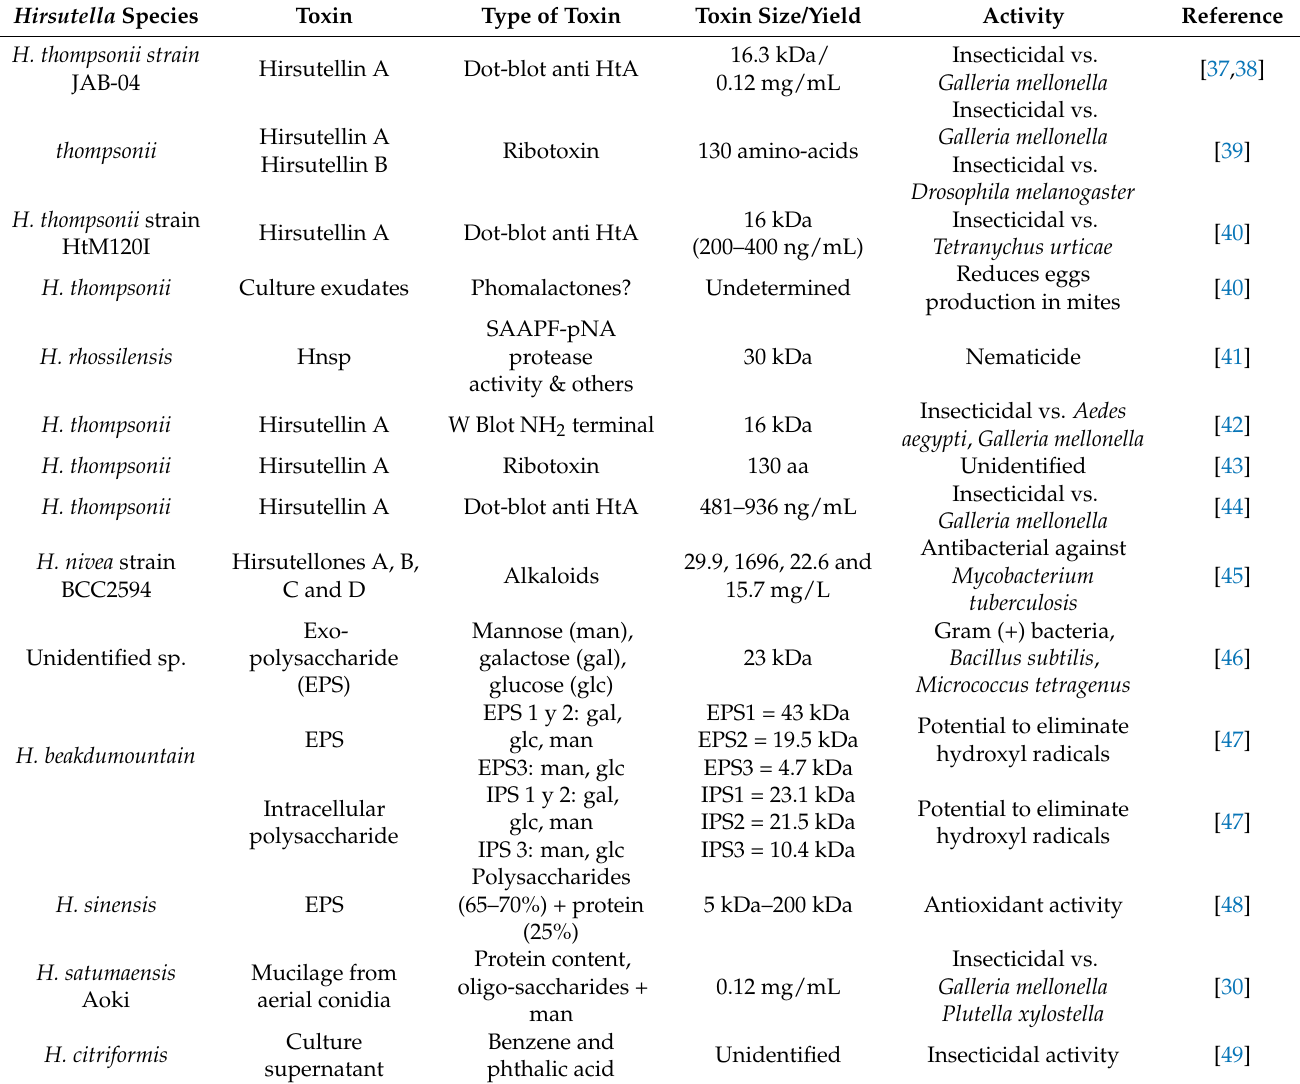
Table 5. Toxins produced by Hirsutella